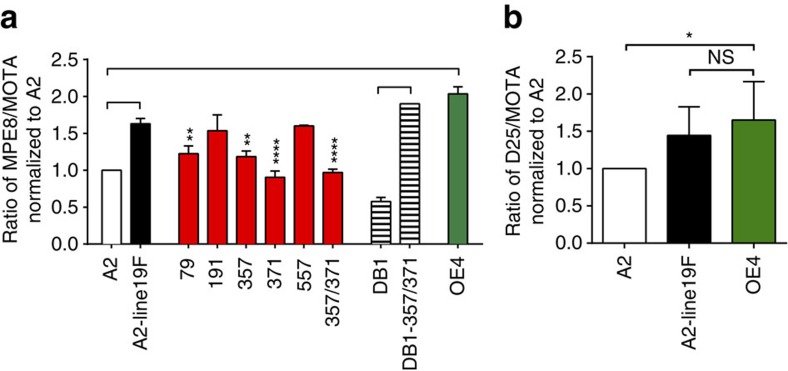
MPE8 and D25 ELISAs.(a) Ratio of direct ELISA using MPE8, a pre-F-specific mAb, to direct ELISA using motavizumab, a total F mAb. Values are normalized to strain A2. For A2-line19F mutants, the asterisks show significant differences compared with A2-line19F. (b) Ratio of direct ELISA using D25, another pre-F-specific mAb, to direct ELISA using motavizumab. All graphs represent the means+s.d.'s of at least two experimental replicates, and data were analysed by one-way ANOVA. When significant, P values are shown as a bracket between groups (P<0.0005) or by asterisk when compared with A2-line19F (*P<0.05; **P<0.005; ***P<0.0005).